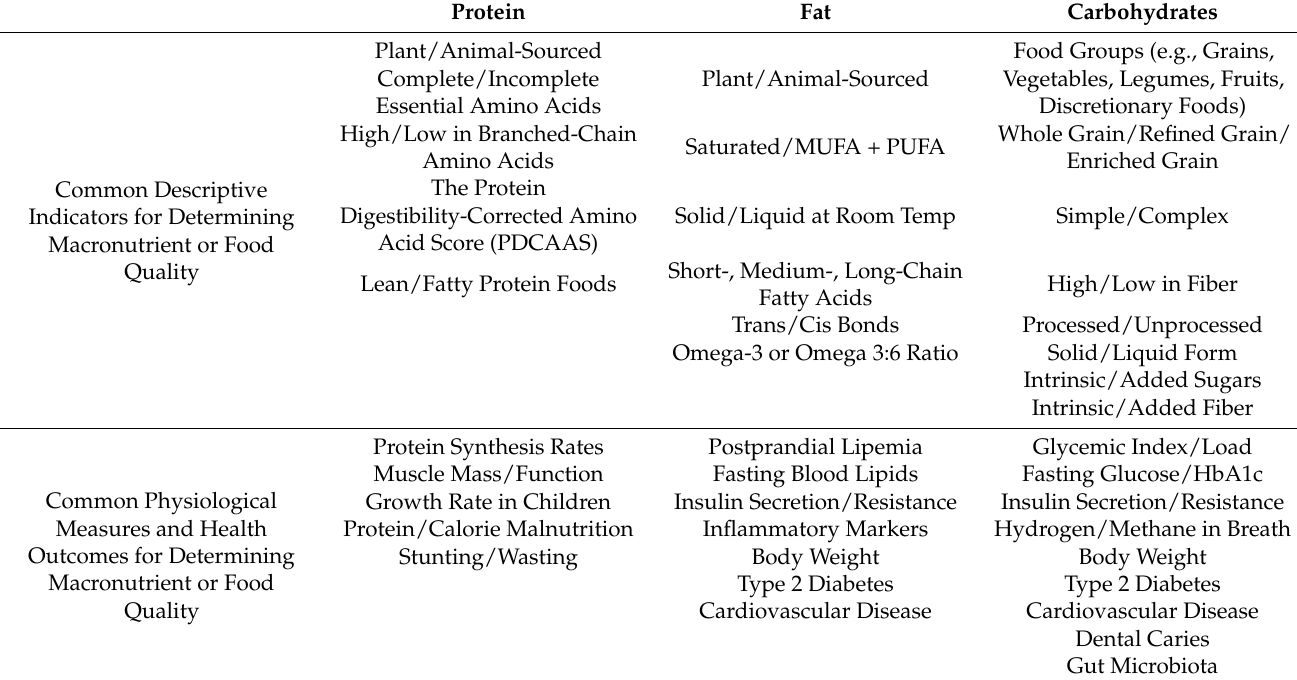
Table 1. Comparison of Macronutrient Quality Indicators.